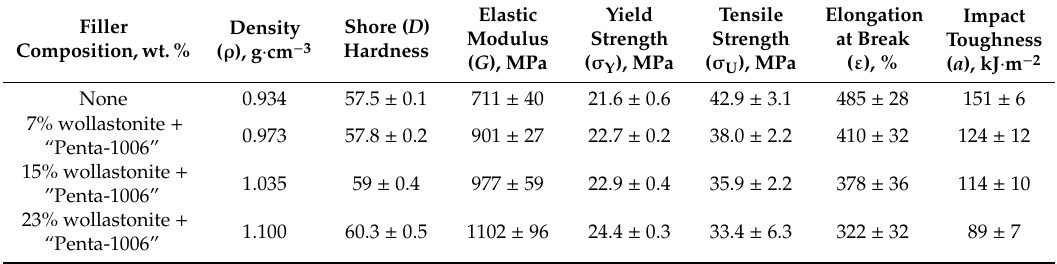
Table 3. The physico-mechanical properties of neat ultrahigh molecular weight polyethylene UHMWPE and the UHMWPE-based composites silanized with the “Penta-1006” coupling agent. Filler Composition,wt.%